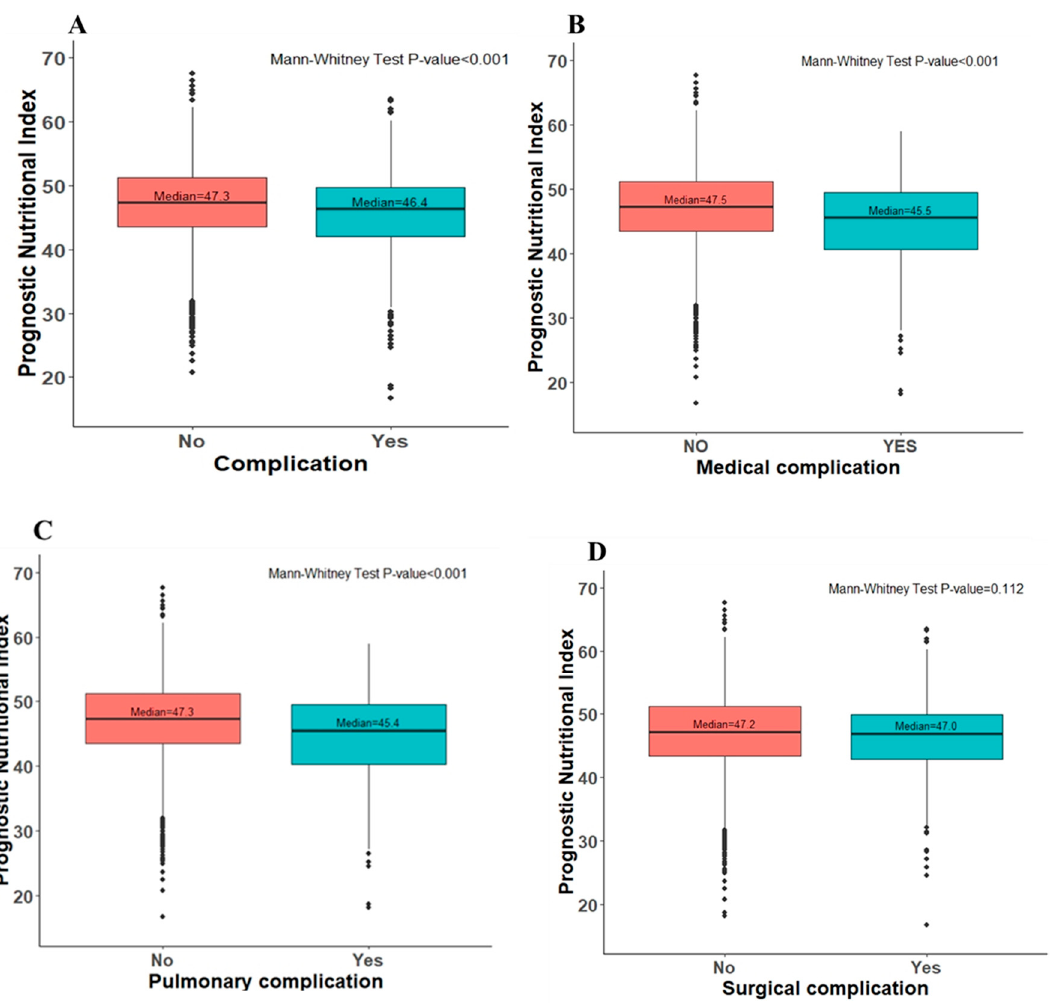
Figure 2. Box-plot analysis in the preoperative PNI score stratified by ( A ) overall complication, ( B ) medical complication, ( C ) pulmonary complication and ( D ) surgical complication event within 30 days after receiving resection surgery.